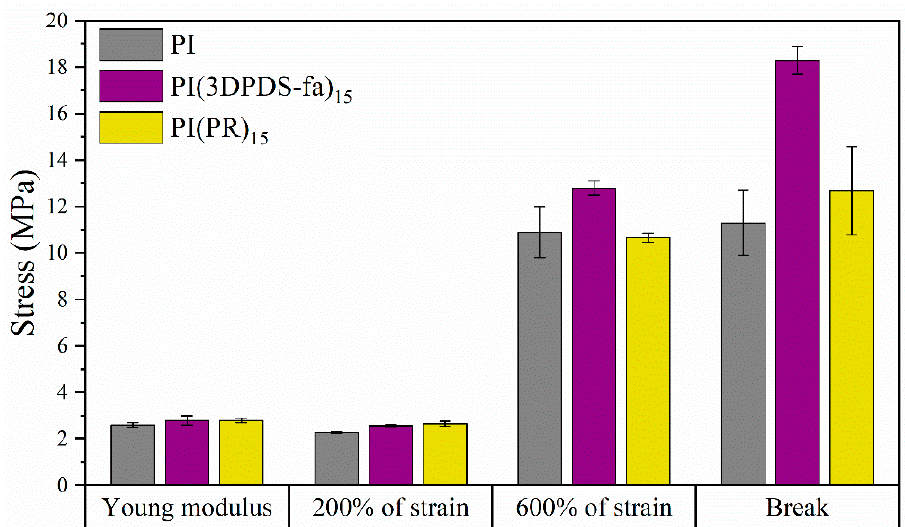
Figure 8. Stress (MPa) (±SD): Young modulus, σ 200% of strain, σ 600% of strain , and σ break (from left to right) of reference compound (PI) and compounds containing 3DPDS-fa, and phenolic resin.